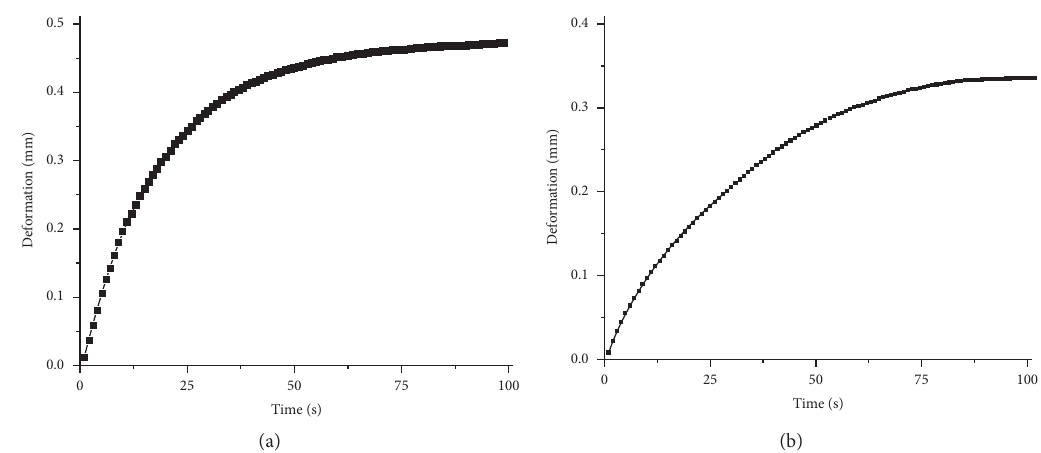
Figure 22: Variation of displacement and deformation with time. (a) The displacement deformation with time at Point 1. (b) The displacement deformation with time at Point